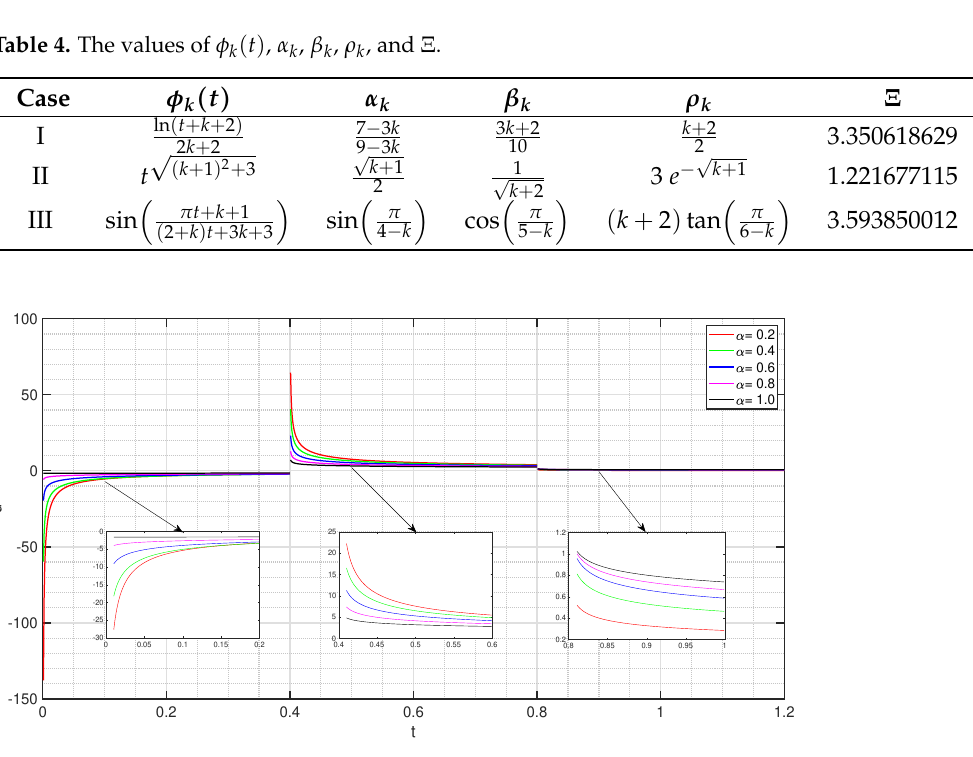
Figure 1. The implicit solutions of Example (49) via α k ∈ { 0.2,0.4,0.6,0.8,1.0 } when φ k ( t ) = ln ( t + k + 2 ) β k = 3 k + 2 , and ρ k = k + 2 for k = 2 10